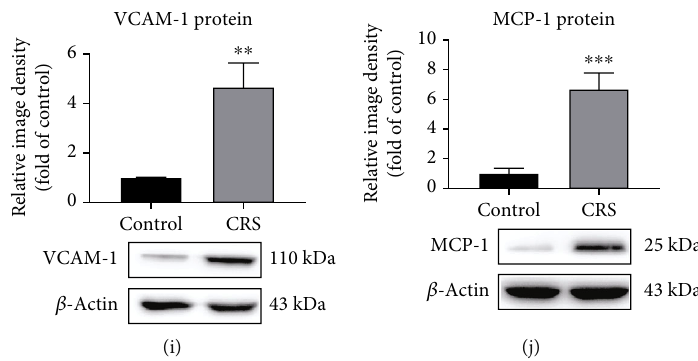
Figure 3: Psychological stress increased cerebrovascular in fl ammation of mice. (a) mRNA and (d) protein expressions of TNF- α were increased after CRS. (b) mRNA and (e) protein expressions of IL-1 β were increased upon CRS. (c) mRNA and (f) protein expressions of IL-6 were upregulated upon CRS. (g) CRS could cause an increase in the expression of VCAM-1 in mRNA and (i) protein levels. (h) CRS could induce an upregulation of the mRNA and (j) protein expressions of MCP-1. Representative immunoblots are displayed at the top of the graphs. Values are mean ± SE . ∗ p < 0 : 05 , ∗∗ p < 0 : 01 , and ∗∗∗ p < 0 : 001 , as compared with the control group.